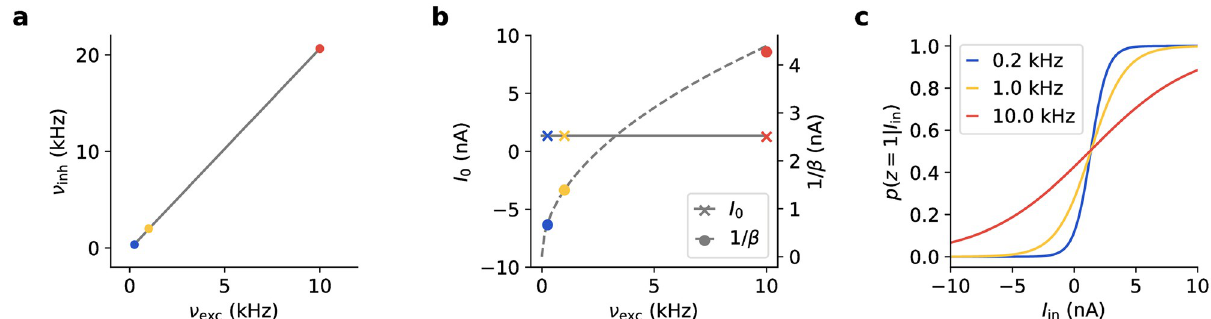
Fig 8. Changing the temperature of the system. The linear relationship ν inh ( ν exc ) in (a) can keep the offset of the response function constant (solid line in (b) ), while only changing the slope of activation functions and thereby the temperature of a network (dashed line line in (b) ). This relationship also reflects the relative strengths of afferent excitatory and inhibitory weights. (c) Three example activation functions with constant offset for different background rates. Colors correspond to those in panel a. Here, we emphasize the binary-state interpretation by plotting p ( z = 1| I in ) = ν out τ ref (cf. Fig 1c).